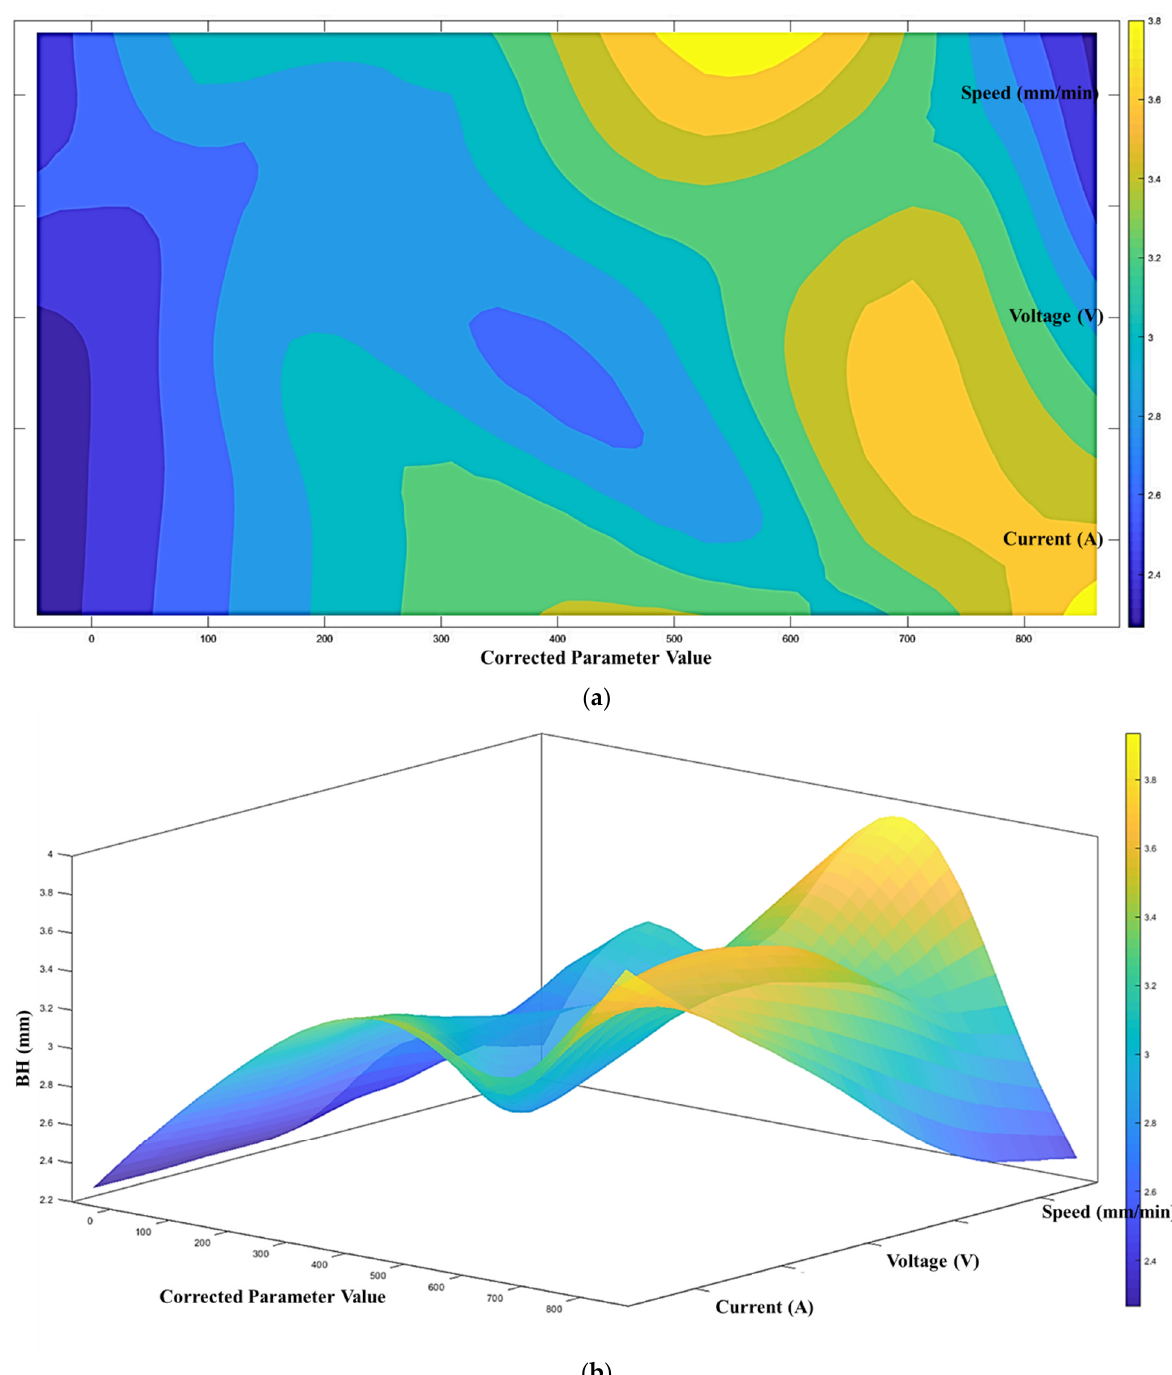
Figure 8. ( a ) Process-quality model (bead height) using current, voltage, and speed (contour), ( b ) process-quality model (bead height) using current, voltage, and speed (3D).